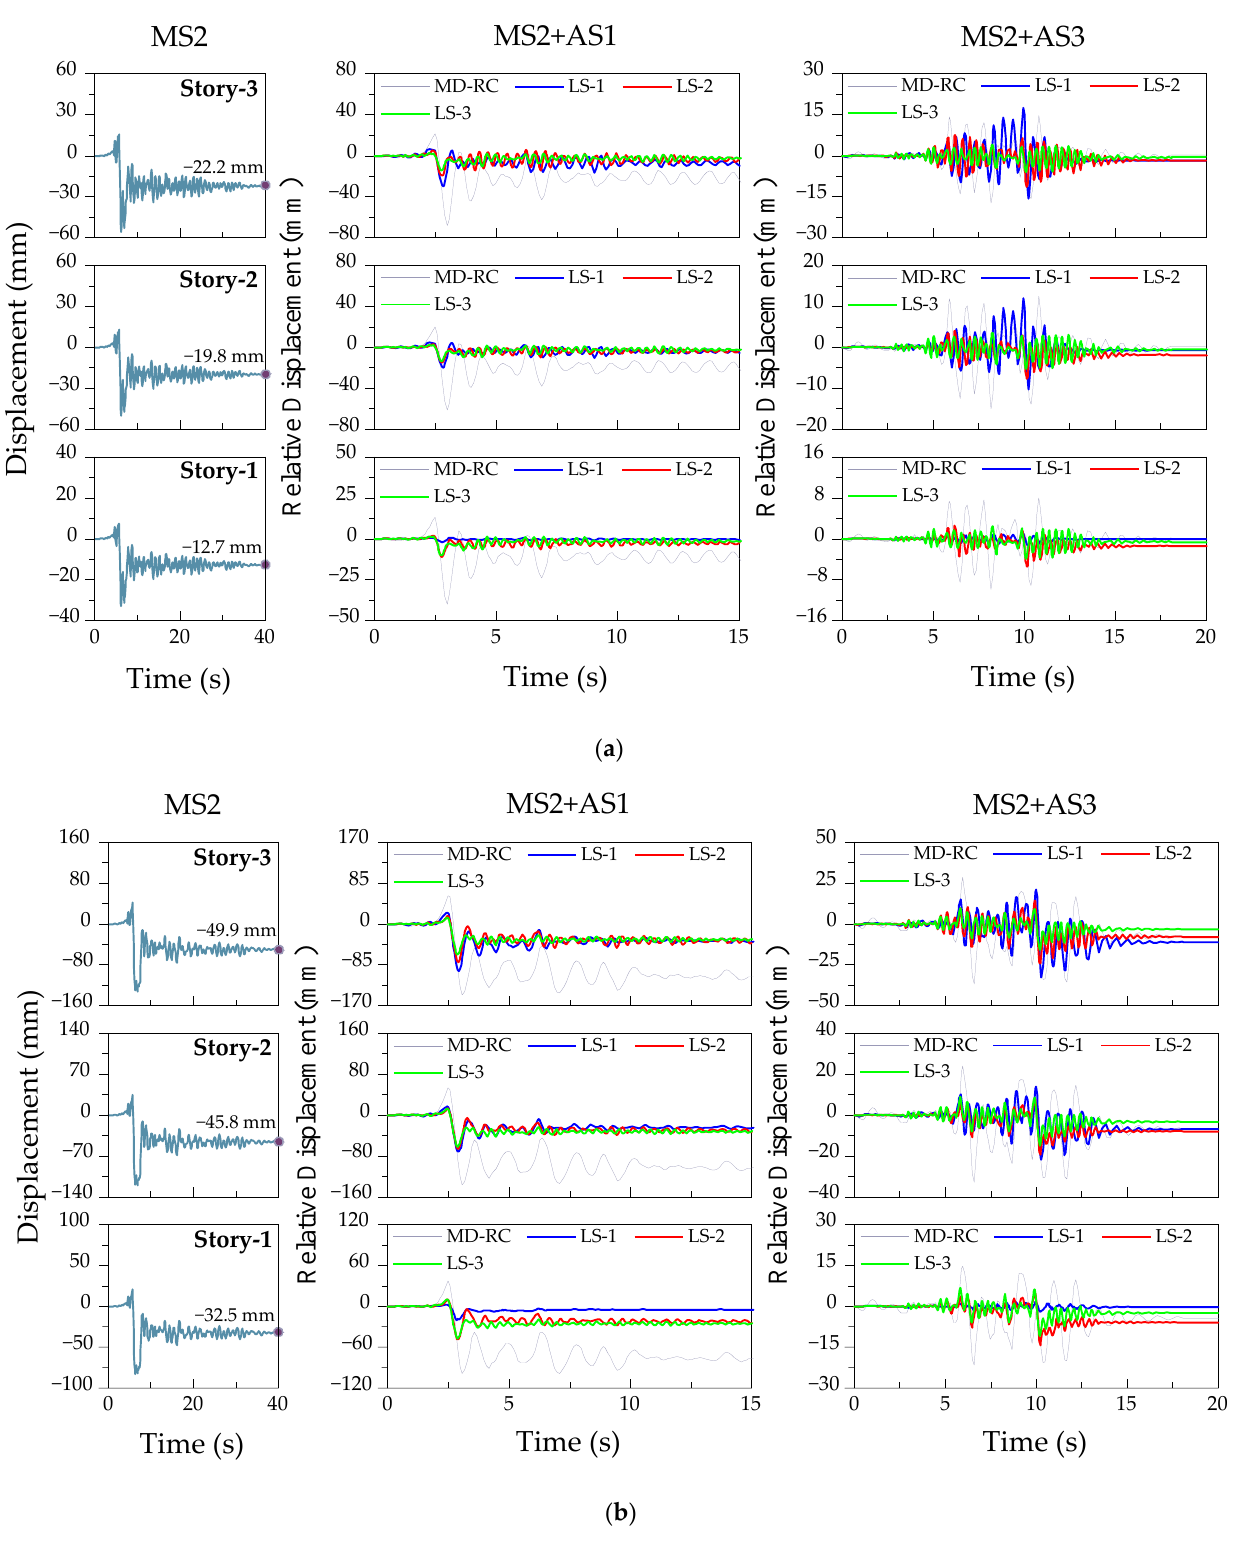
Figure 11. Displacement time histories of DS1 ( a ) and DS2 ( b ) damage states MD-RC frame due to MS2 mainshock before and after retrofitting subjected to AS1 and AS3 aftershocks.